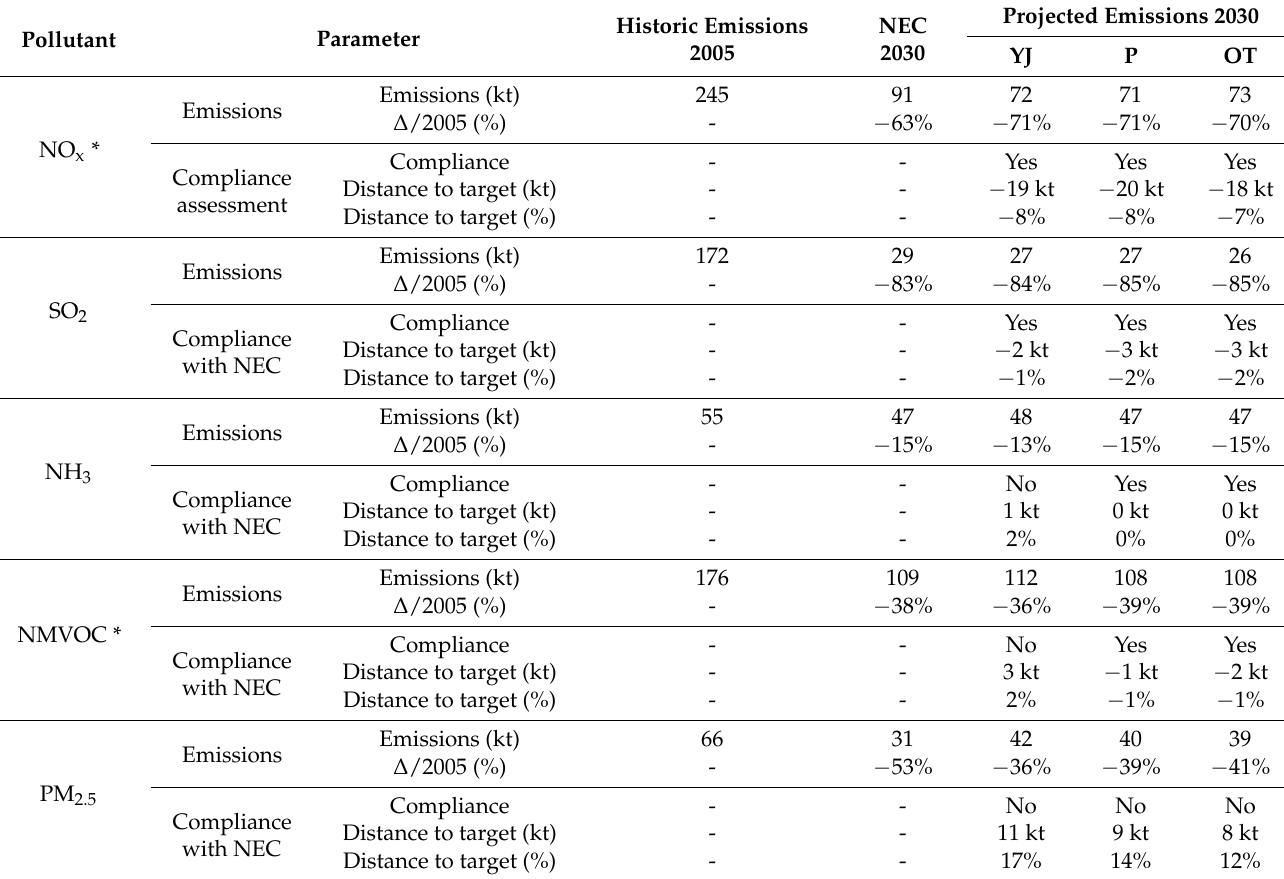
Table 3. National emission reduction commitments compliance according to CNR2050 scenarios, for the 2030-time horizon.